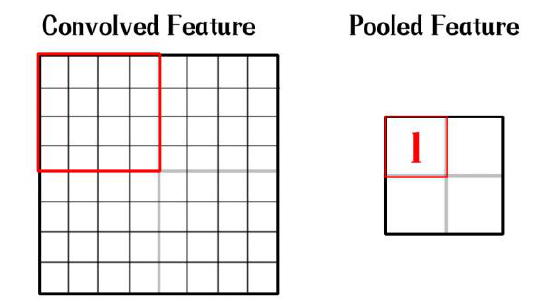
Figure 2. Pooling Layer of CNN